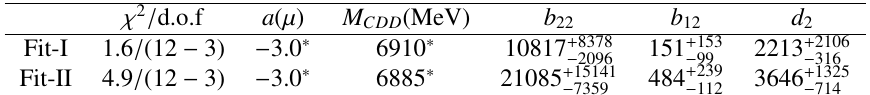
Figure 1. J /ψ J /ψ event distribution around the resonant region of the X (6900).